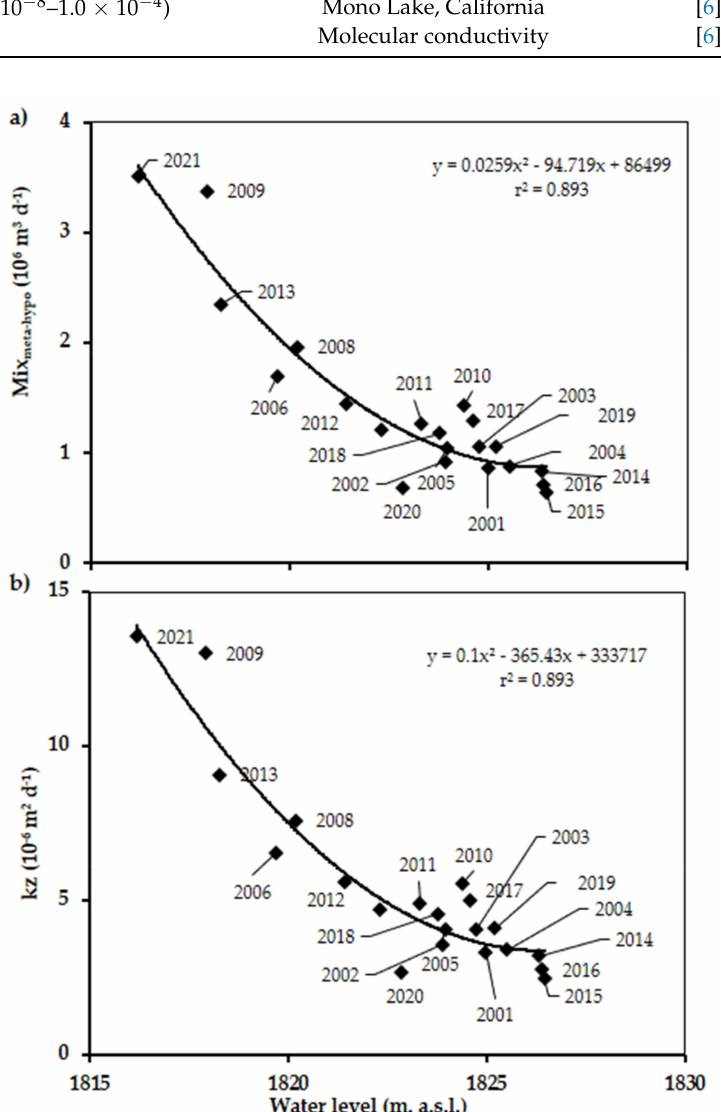
Figure 5. ( a ) Mean vertical mixing rates (Mix meta-hypo , 10 6 m 3 day − 1 ) and ( b ) Kz (m 2 s − 1 ) plotted against the annual minimum water level (m a.s.l.) of VB during 2001–2021. Vertical nutrient fluxes toward the epilimnion (Table 1) also varied inversely with the lake ´ s water level, following a pattern similar to that of Mix meta-hypo and Kz (Figure 6).